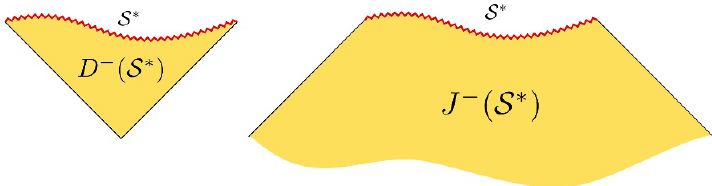
Figure 2 . Generic terminal set S ∗ (in red) and its past domain of dependence D − ( S ∗ ) and causal past J − ( S ∗ ) .